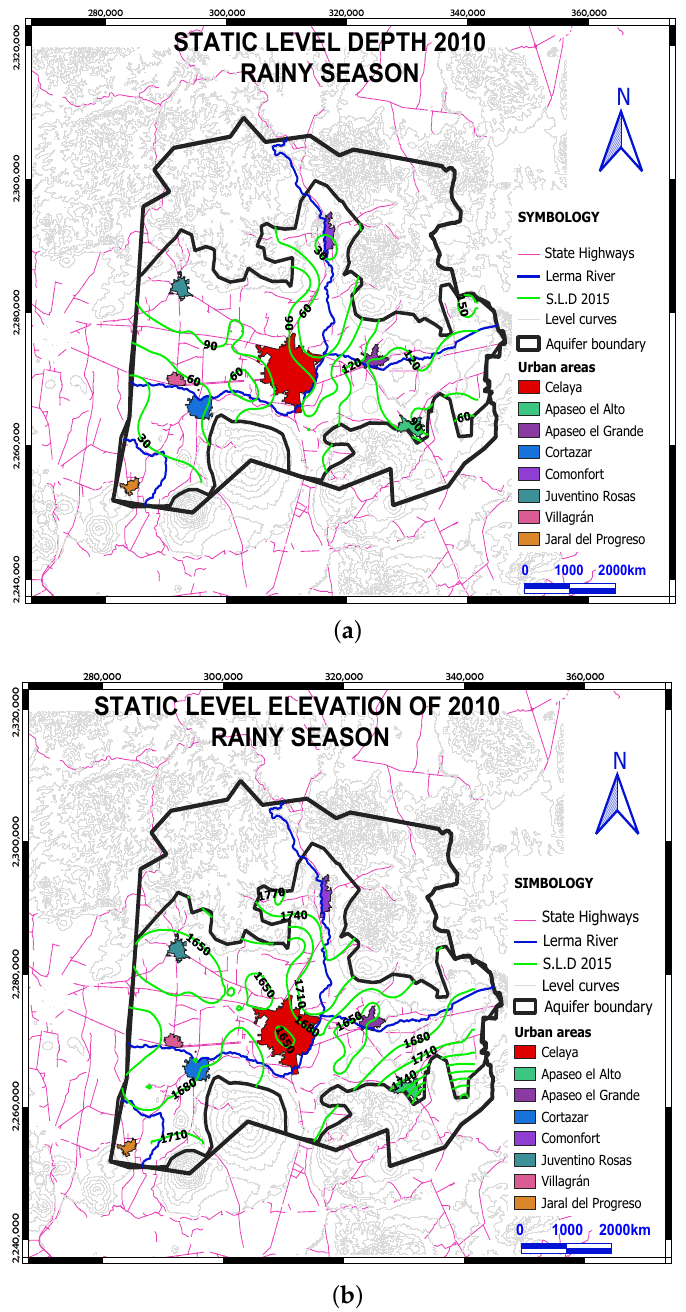
Figura 1.16: Temporada de Lluvias: Elevaci´on del nivel est´atico en el a˜no 2010. Figure 6. Rainy season of 2010. ( a ) Distribution of static level depth lines. ( b ) Distribution of static level elevation